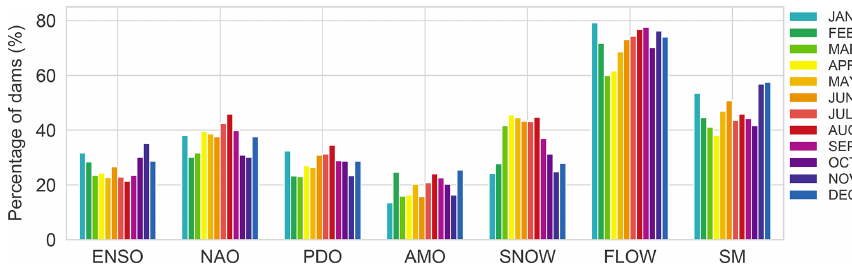
Figure 2. Percentage of dams whose inflow is significantly correlated with lagged predictors (ENSO, NAO, PDO, AMO, and snowfall) and 1-month ahead predictors (inflow and soil moisture) in each calendar